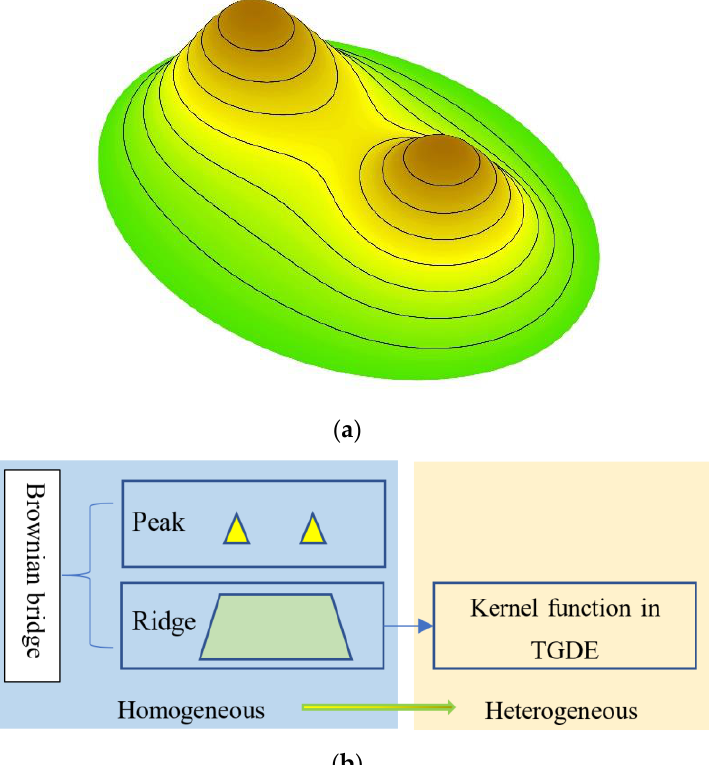
Figure 2. ( a ) Schematic diagram of probabilistic PPA [3] and ( b ) its two-layer